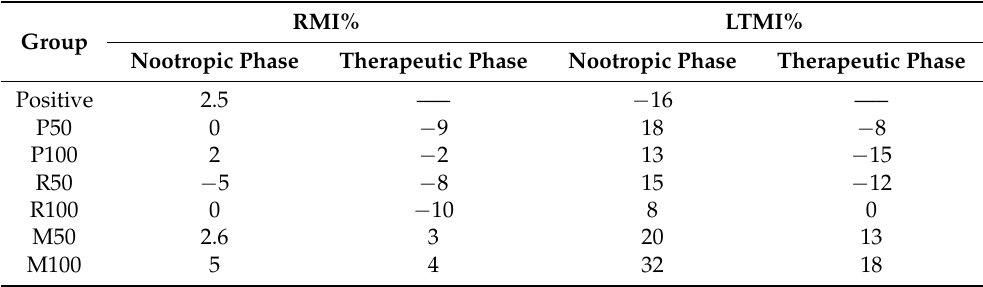
Table 1. Values of RMI and LTMI results. Nootropic data were compared with normal groups, while therapeutic data were compared with positive